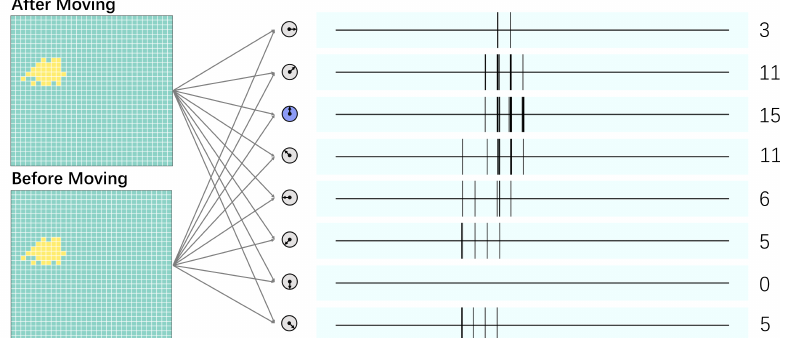
Figure 6. Computer simulation of machanism for detecting the moving direction of a one-pixel pattern being moved at 1 unit along the y direction (an UPWARD movement) in two dimensions. (LEFT) images before and after moving, (RIGHT) responses of neurons